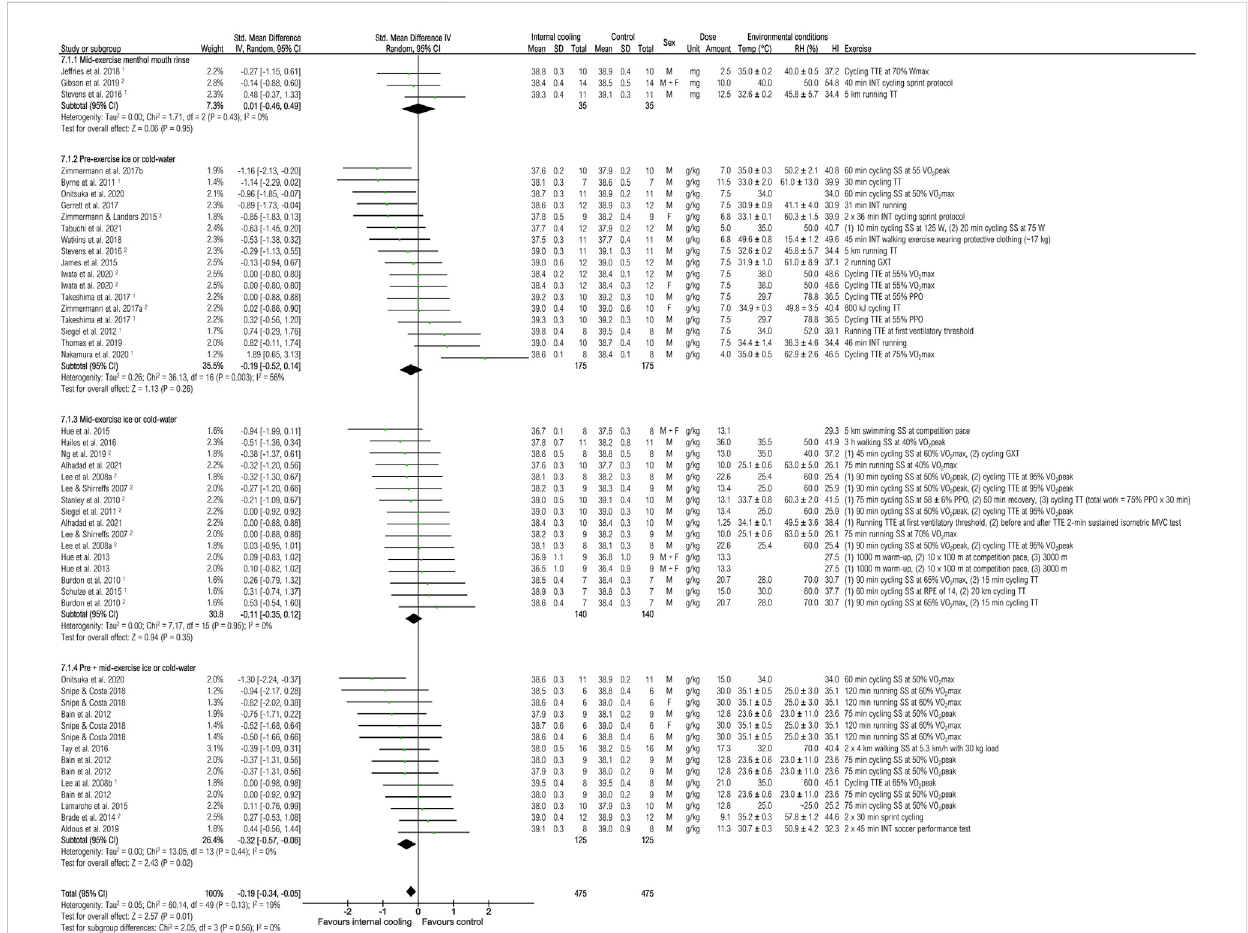
FIGURE 5 Meta-analysis of standardized mean difference in core temperature [ ° C] with 95% CI between internal cooling and control. 1 Studies with signi fi cant positive performance effects of internal cooling. 2 Studies with no performance effects of internal cooling. F, female; GXT, graded exercise test; HI, heat index; INT, intermittent exercise; M, male; MVC, maximum voluntary contraction; PPO, peak power output; RH, relative humidity; RPE, rate of perceived exertion; SS, steady-state exercise; Temp, ambient temperature; TT, time trial; TTE, time to exhaustion; VO 2 max, maximum oxygen consumption; Wmax, maximum